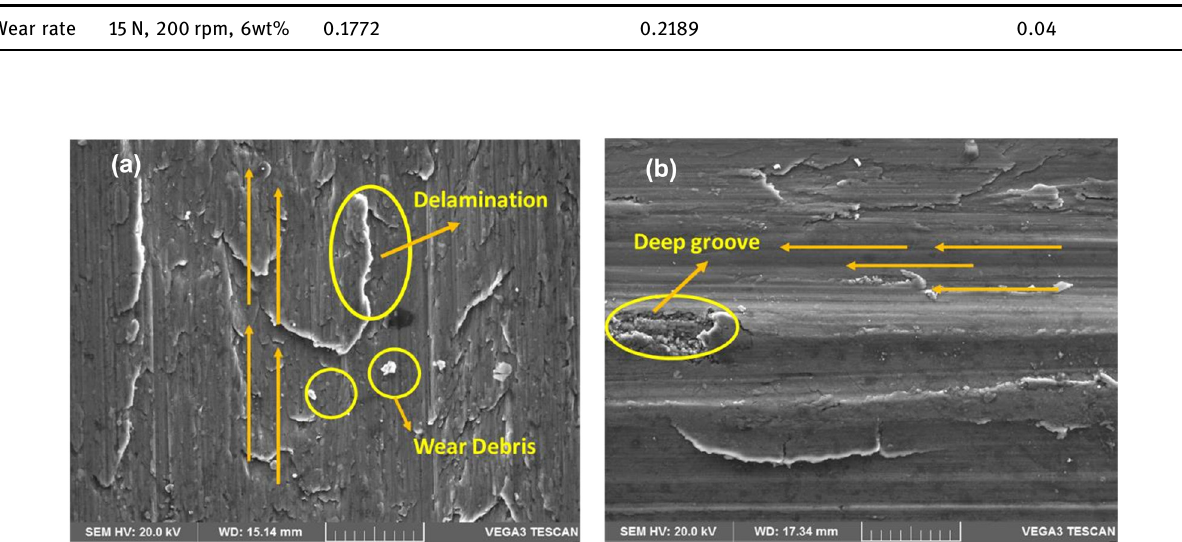
Figure 10: SEM images of the wear samples: ( a ) 25 N load, 300 rpm speed, and 4 wt% of B 4 C and ( b ) 15 N load, 200 rpm speed, and 2 wt% B 4